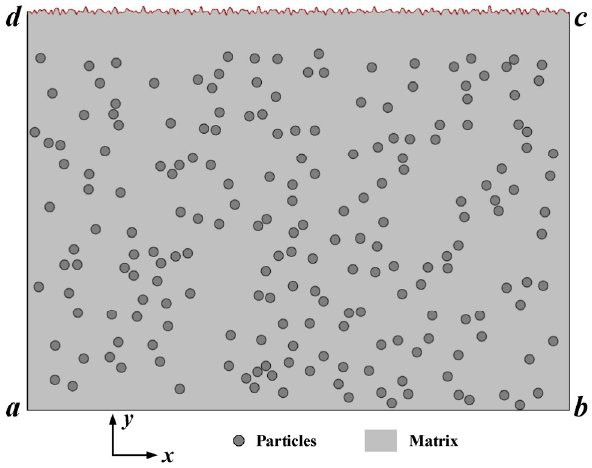
Fig. 1 The two-dimensional FE model of